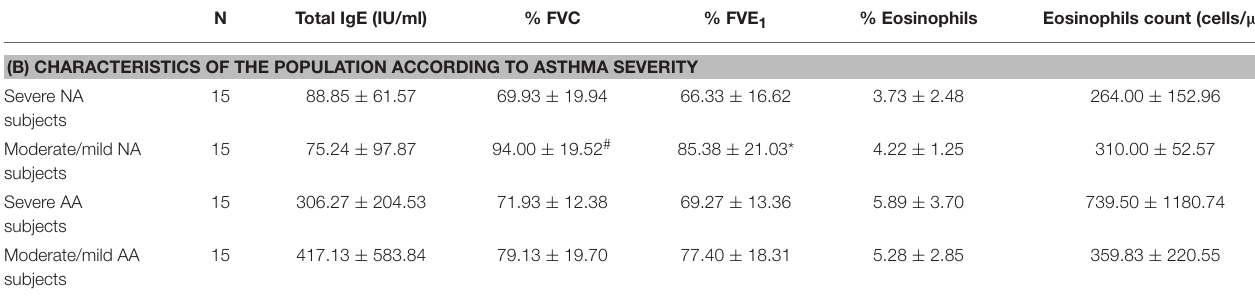
TABLE 1B | Characteristics of the study population.